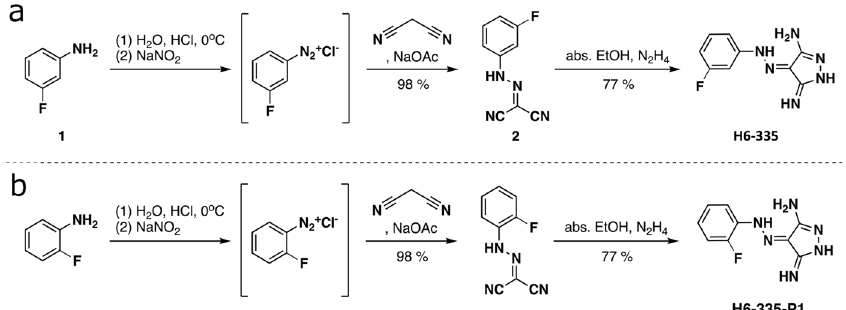
Fig. 2 Chemical synthesis of H6-335 and H6-335-P1. Synthesis of (Z)-4-(2-(3- fl uorophenyl)hydrazineylidene)-5-imino-4,5-dihydro-1H-pyrazol- 3-amine (H6-335) ( a ) and 4-[(2- fl uorophenyl) hydrazinylidene]pyrazole-3,5-diamine (H6-335-P1) ( b ) in a two-step procedure involving diazotation of the arylamines and condensation with malonodinitrile, followed by cyclocondensation with